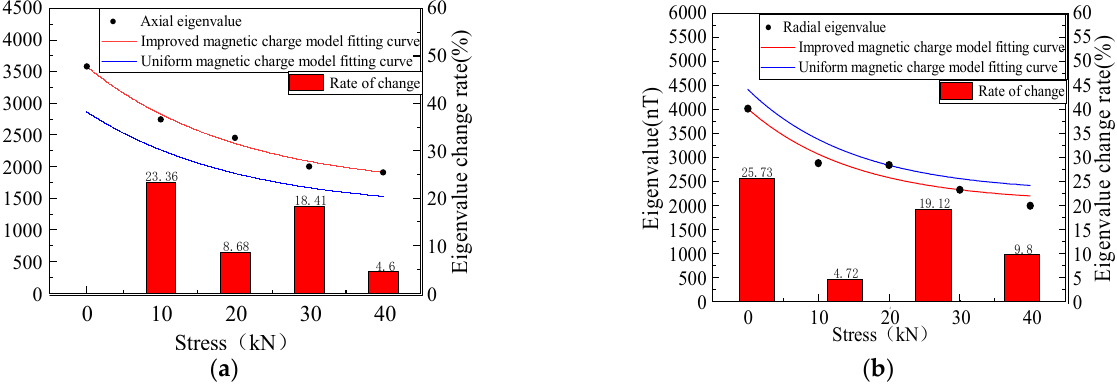
Figure 18. Eigenvalues under different stresses. ( a ) Axial component fitting and eigenvalue analysis. ( b ) Radial component fitting and eigenvalue analysis.